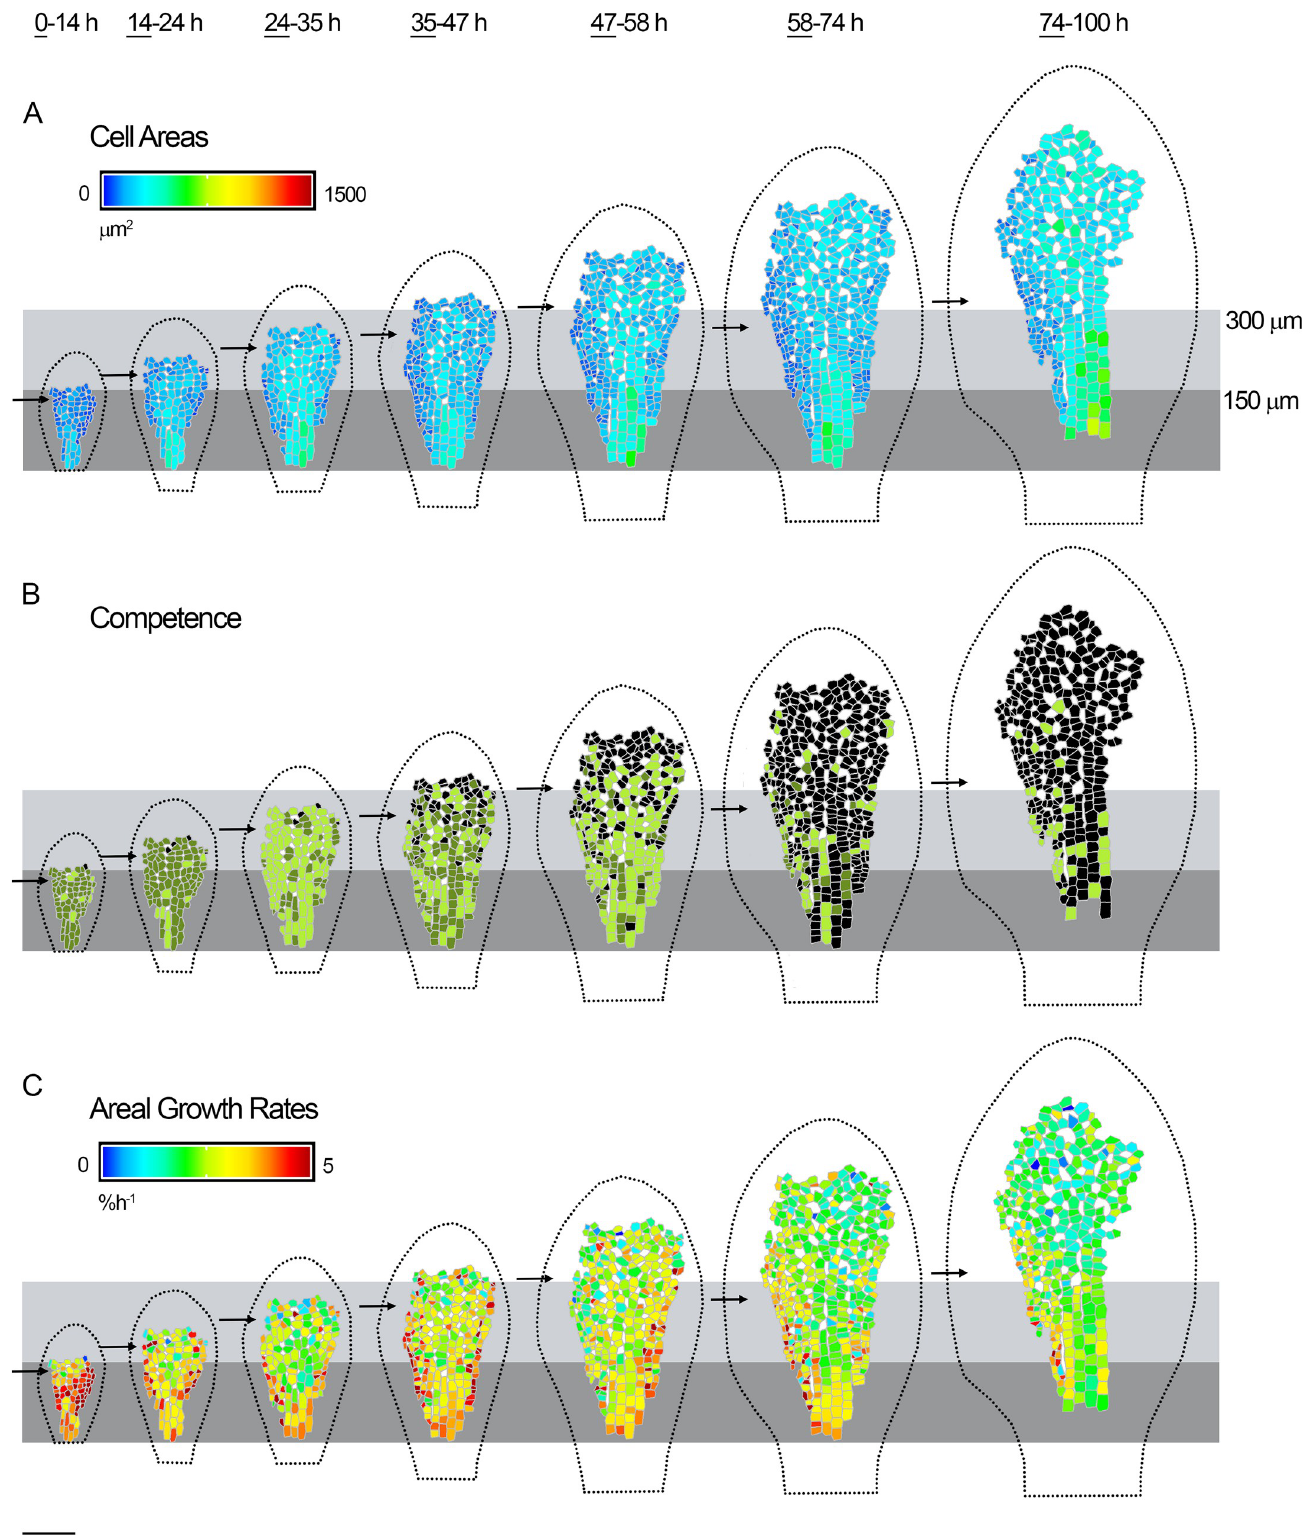
Fig 6. Dynamics of cell division and growth in the spch subepidermis. Cells amenable to tracking in the subepidermal layer of the spch leaf shown in Fig 1. Data shown on first time point (underlined) for each tracking interval. ( A ) Cell areas (heat map). ( B ) Cells that were competent to divide (green) and either